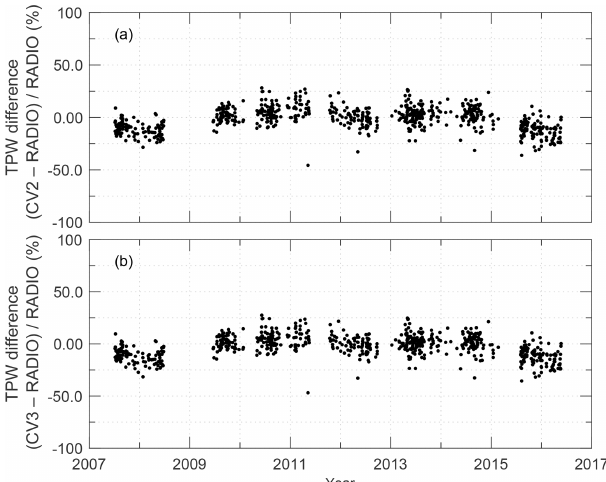
Figure 11. Time series of relative differences between (a) level 2.0 V2 TPW from the Cimel sun photometer and the radiosondes and (b) from level 2.0 V3 TPW from the Cimel sun photometer, during the period